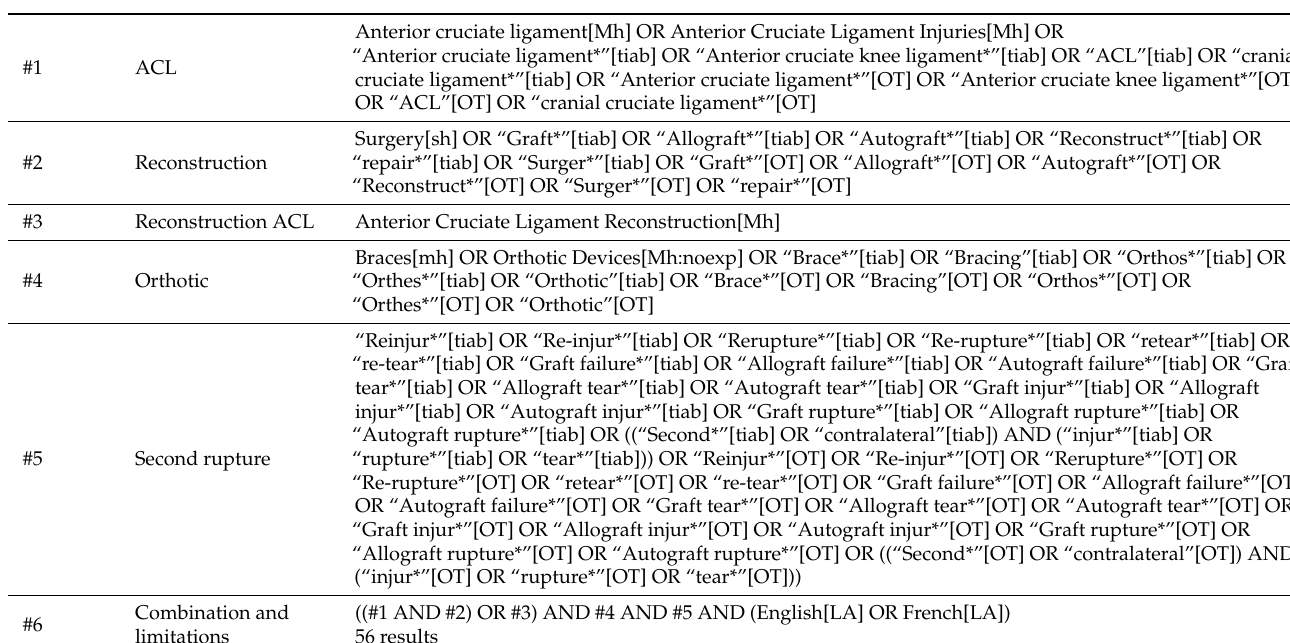
Table A1. PubMed 9 June 2020.